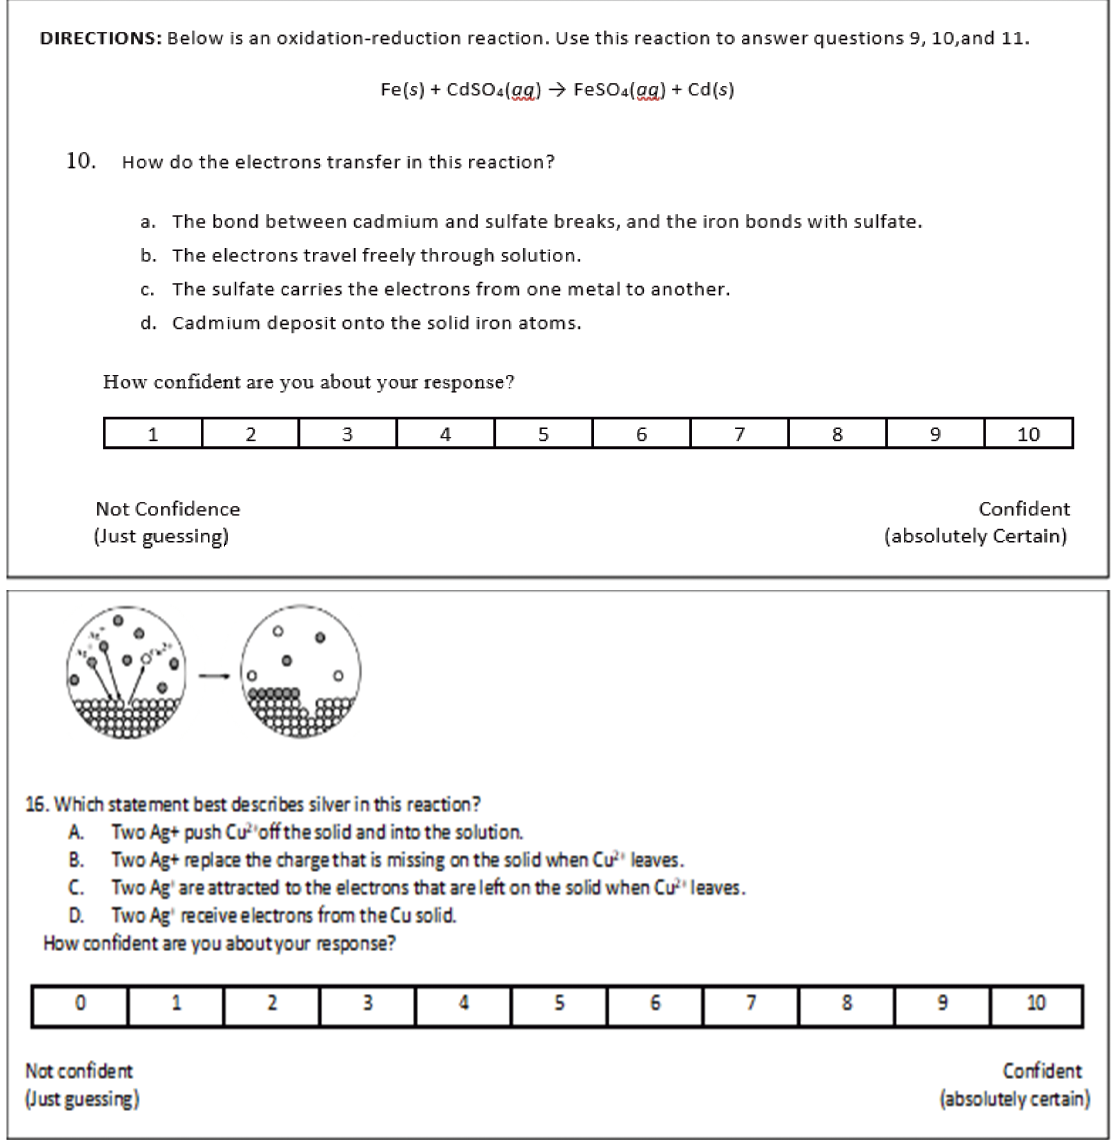
Figure 1. A one-tier item with the confidence scale on the Redox Concept